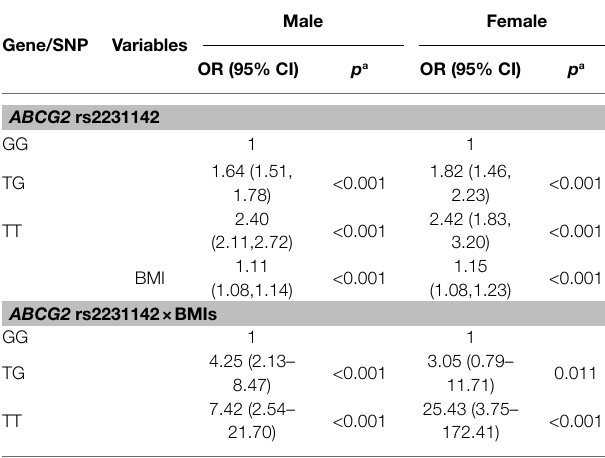
TABLE 3 | Associations of ABCG2 rs2231142 and BMI with hyperuricemia.